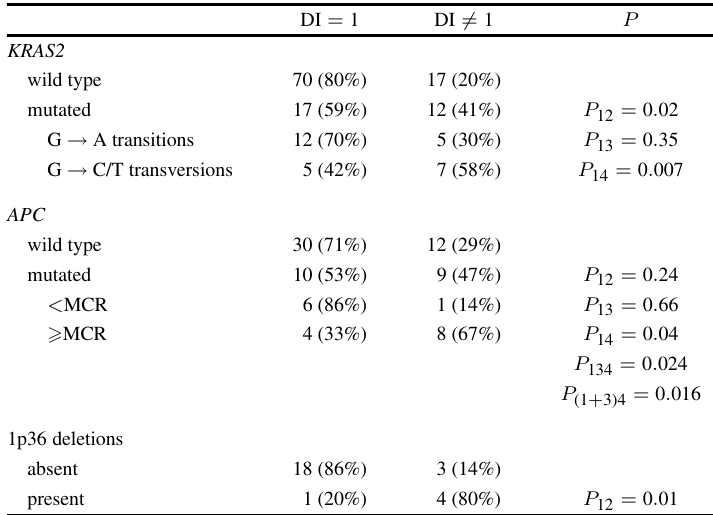
KRAS2 and APC mutations and deletions at 1p36 versus DNA Index among human spo- radic colorectal